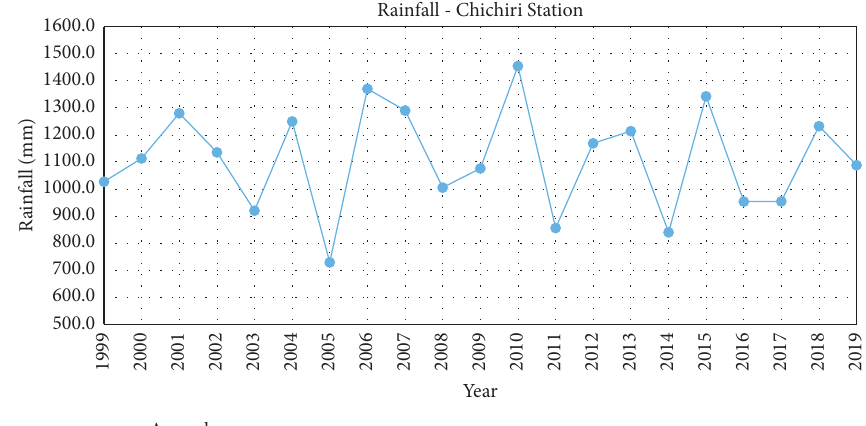
Figure 4: Total annual rainfall trends (source: Malawi Department of Climate Change and Meteorological Services).